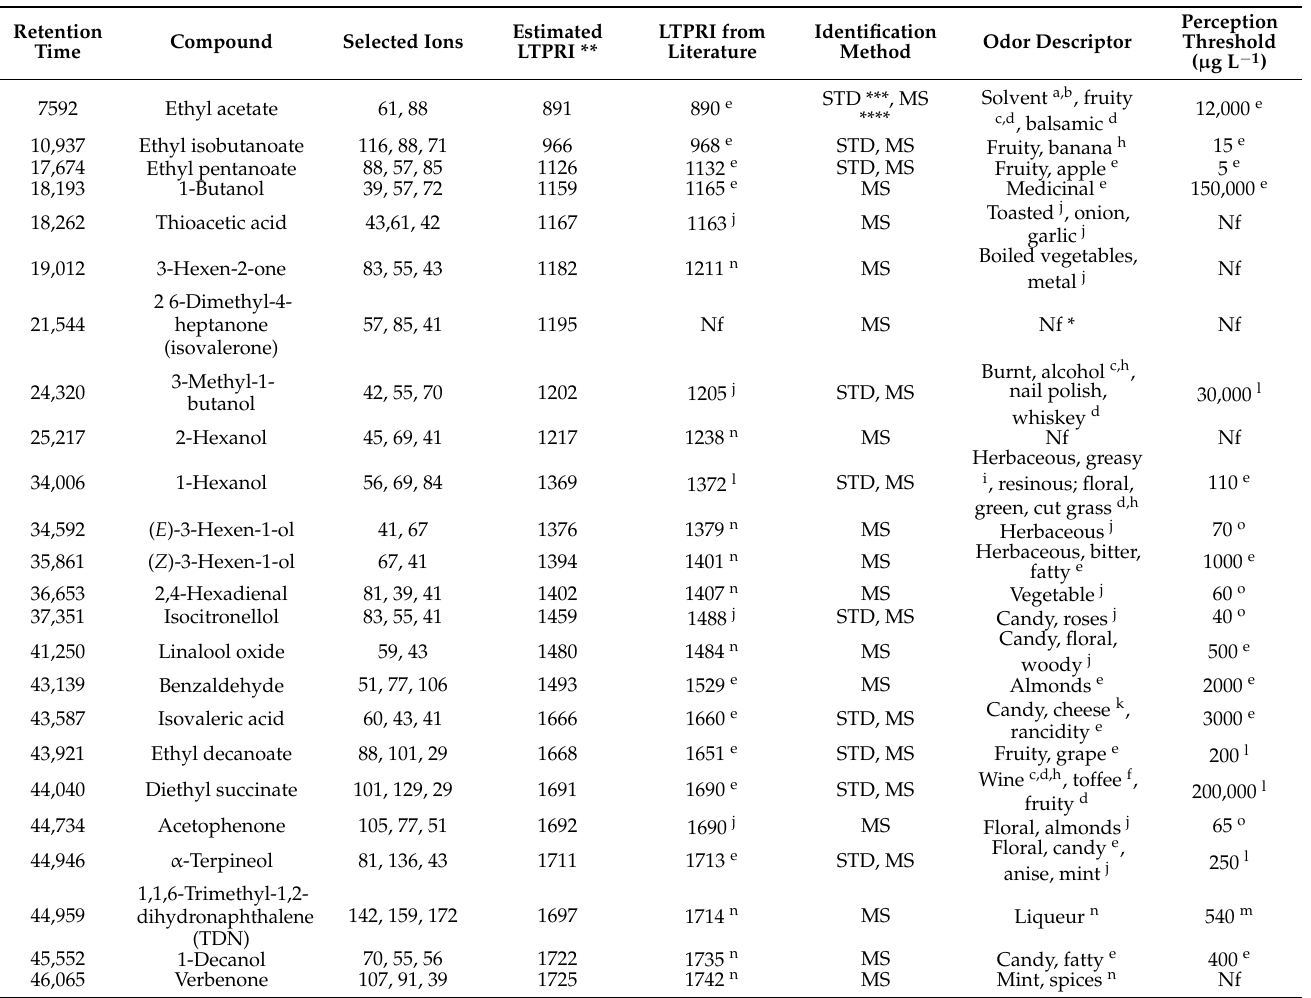
Table 1. Volatile compounds in unfermented Sauvignon Blanc (SB) must, along with their respective retention times, identification ions, retention indices, identification methods, odor descriptor, and perception